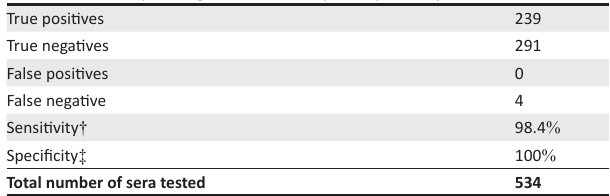
TABLE 3: Summary of diagnostic sensitivity and specificity.